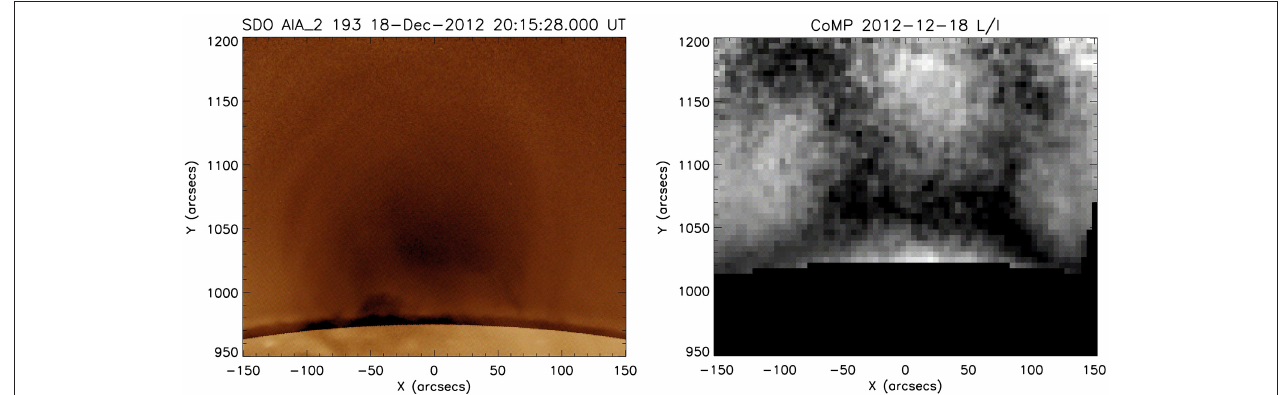
FIGURE 1 | Left: Cavity observed on 2012 December 18 by SDO/AIA 193 Å. Right: LOS-integrated linear polarization fraction ( L / I ) from CoMP showing lagomorphic, or rabbit-head shaped, structure. The occulting disk of CoMP extends to 1.05 R ⊙